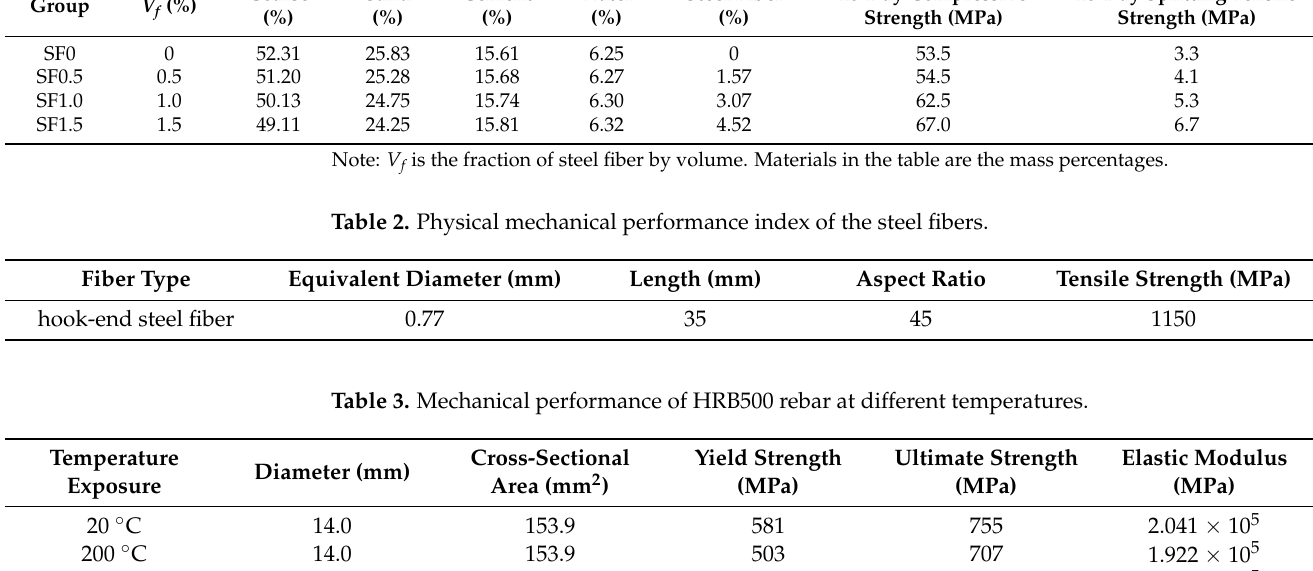
Table 3. Mechanical performance of HRB500 rebar at different temperatures.